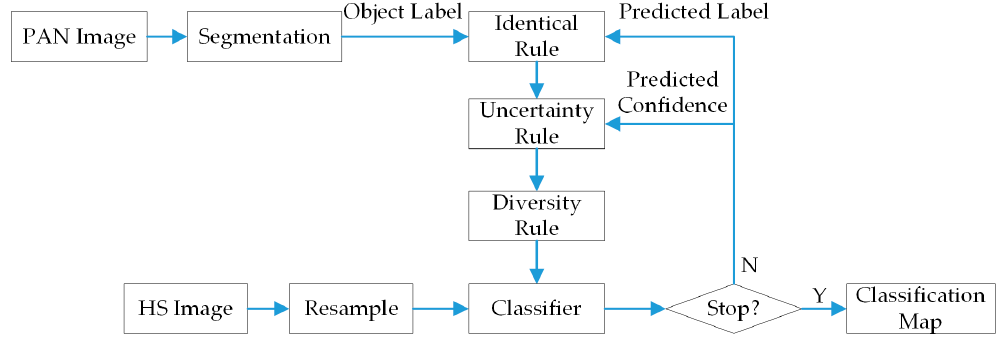
Figure 2. The main framework of the presented scheme.